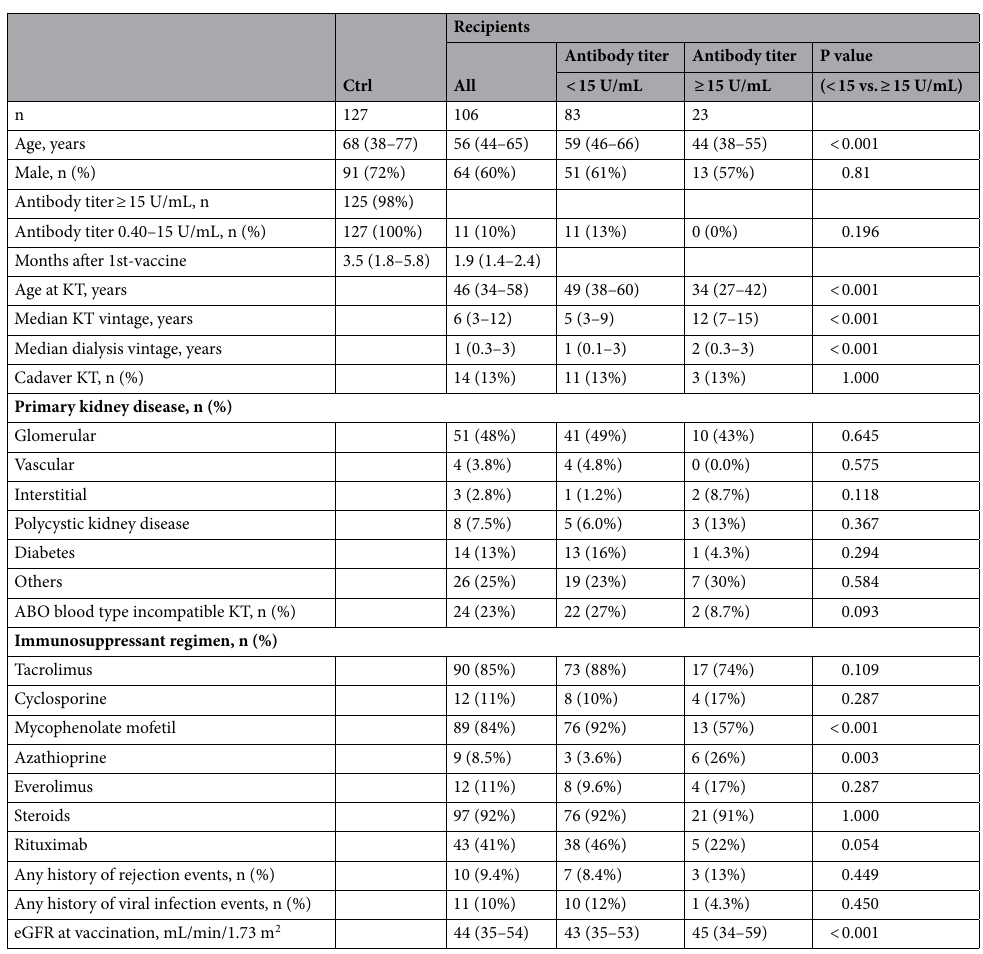
Table 1. Background of participants. KT kidney transplant, eGFR estimated glomerular filtration